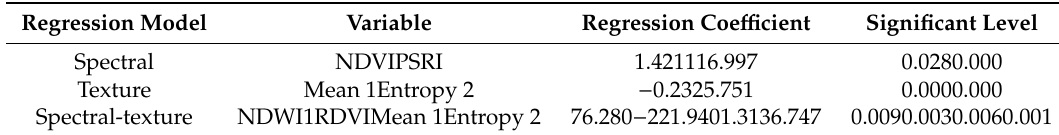
Table 3. Selected features and regression parameters.